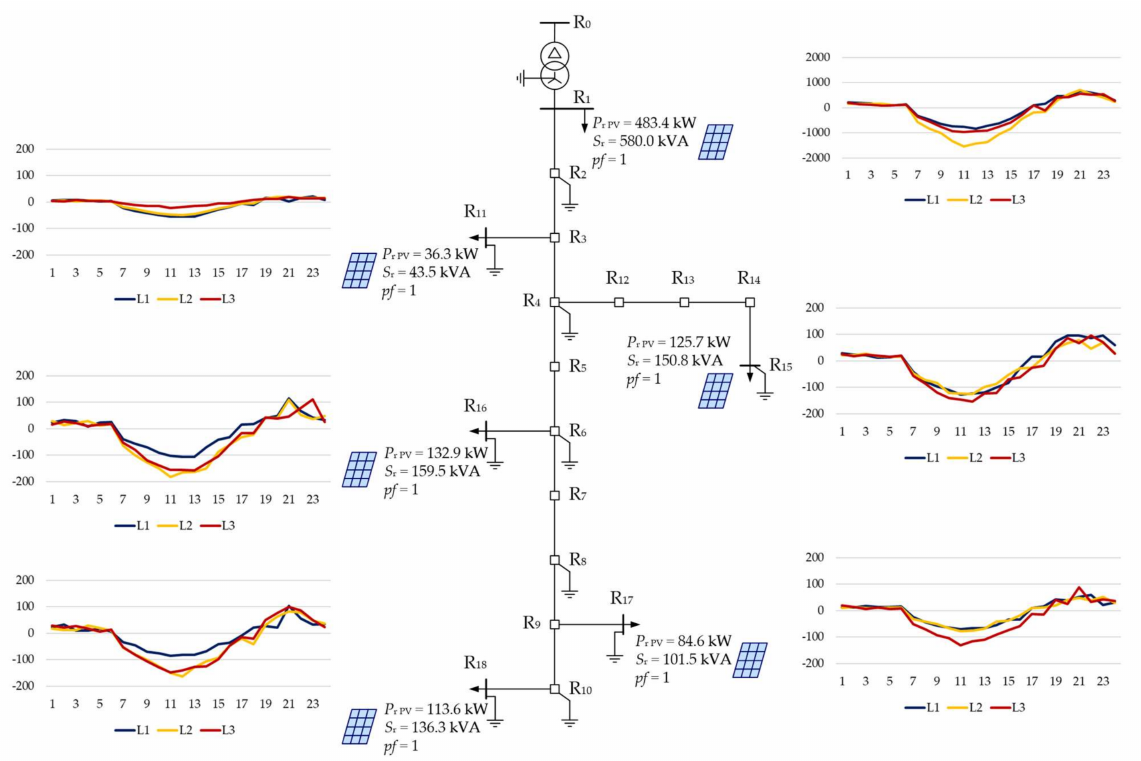
Figure A14. Daily simulation results for variant V10: phase currents